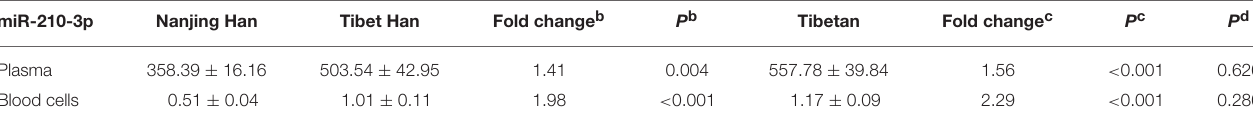
TABLE 2 | The concentrations of miR-210-3p in plasma and peripheral blood cells from Nanjing Han, Tibet Han, and Tibetan determined by qRT-PCR assay a . miR-210-3p Nanjing